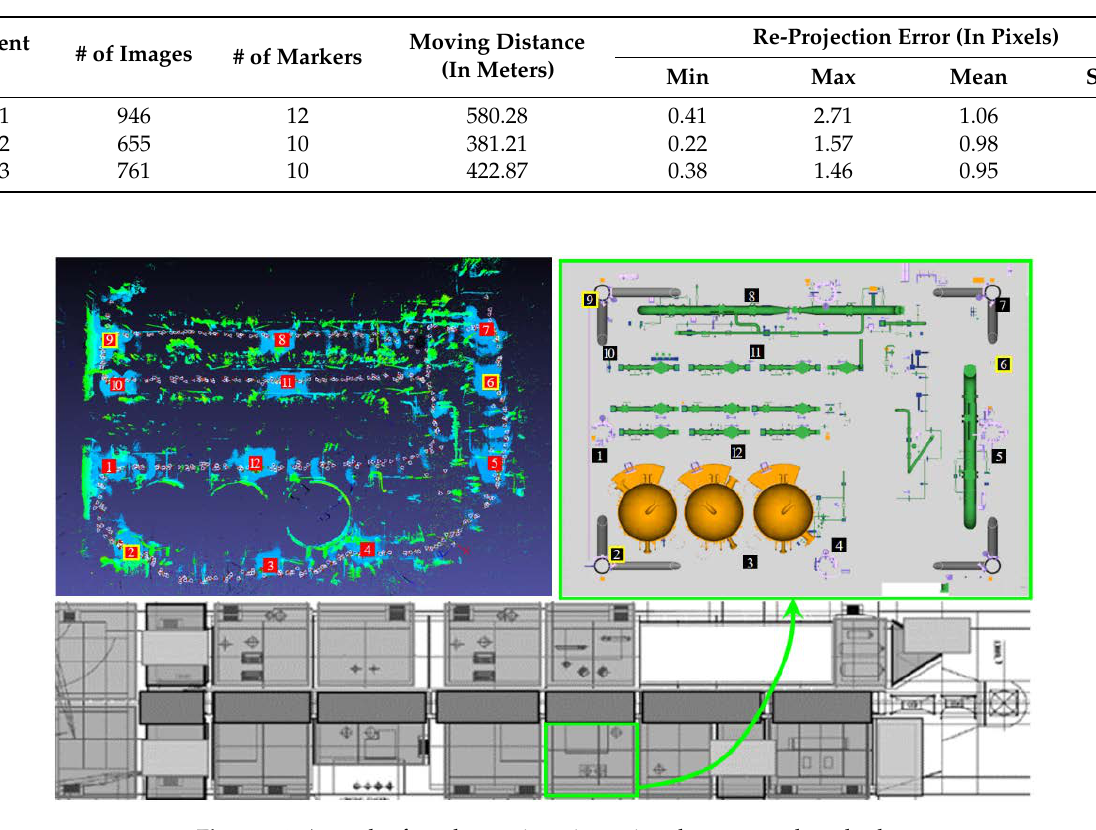
Figure 14. A result of marker registration using the proposed method. Table 1. Accuracy evaluation using re-projection error check.